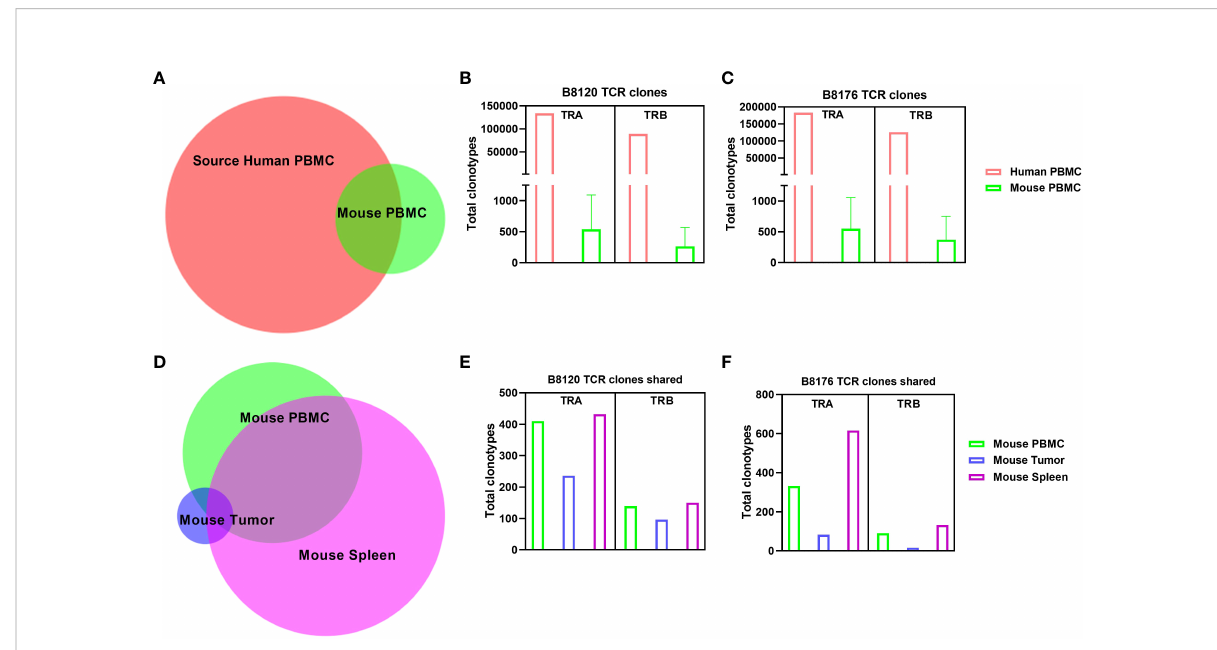
FIGURE 3 Comparison of human TCR sequences in human and humanized mouse samples (A) The overlap of clonotypes between human PBMCs and mouse PBMCs. (B, C) The number of TRA and TRB clones in human and mouse blood samples in the models B8120 (B) and B8176 (C) . (D) The extent of overlap of clones in different mouse tissues. (E, F) Bar charts of the B8120 (E) and B8176 (F) clonotypes that are common in human PBMCs injected into mice and mouse tissues after